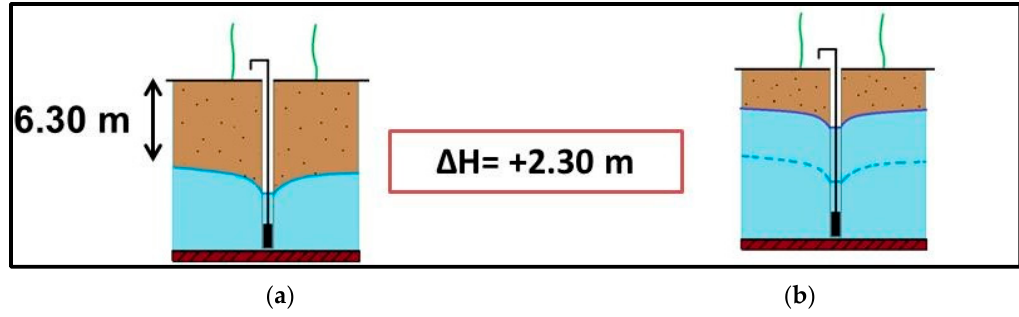
Figure 8. Mock-up with the rise in water level resulting from artificial recharge operations in El Carracillo aquifer. Groundwater levels before ( a ) and after MAR operations ( b ).